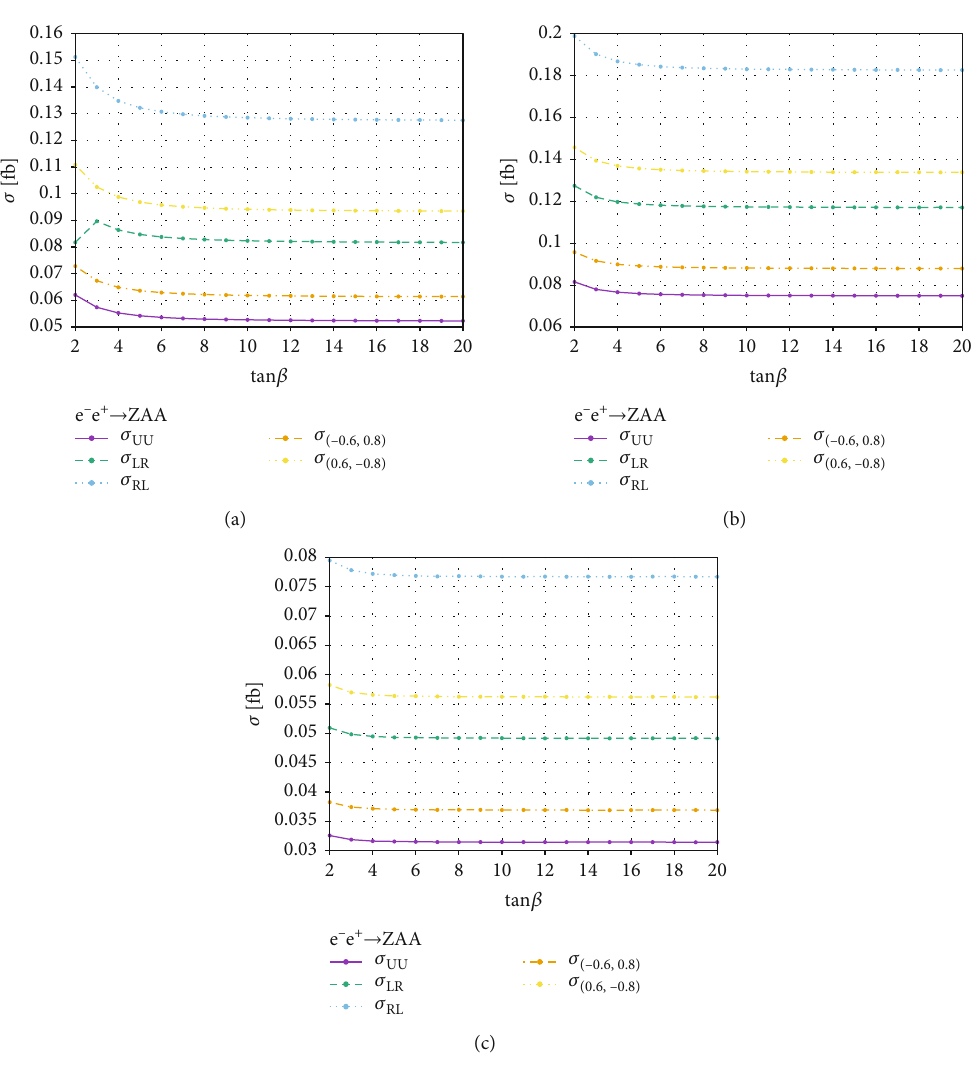
Figure 7: Figure (a) is plotted to discuss the behaviour of σ ð e + e − ⟶ ZAA Þ at ffiffi p ffiffi p = 1TeV and = 3 TeV , plotted at s s